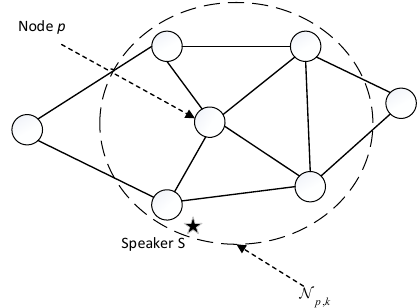
Figure 1. Diagram of speaker tracking in the distributed acoustic sensor network.